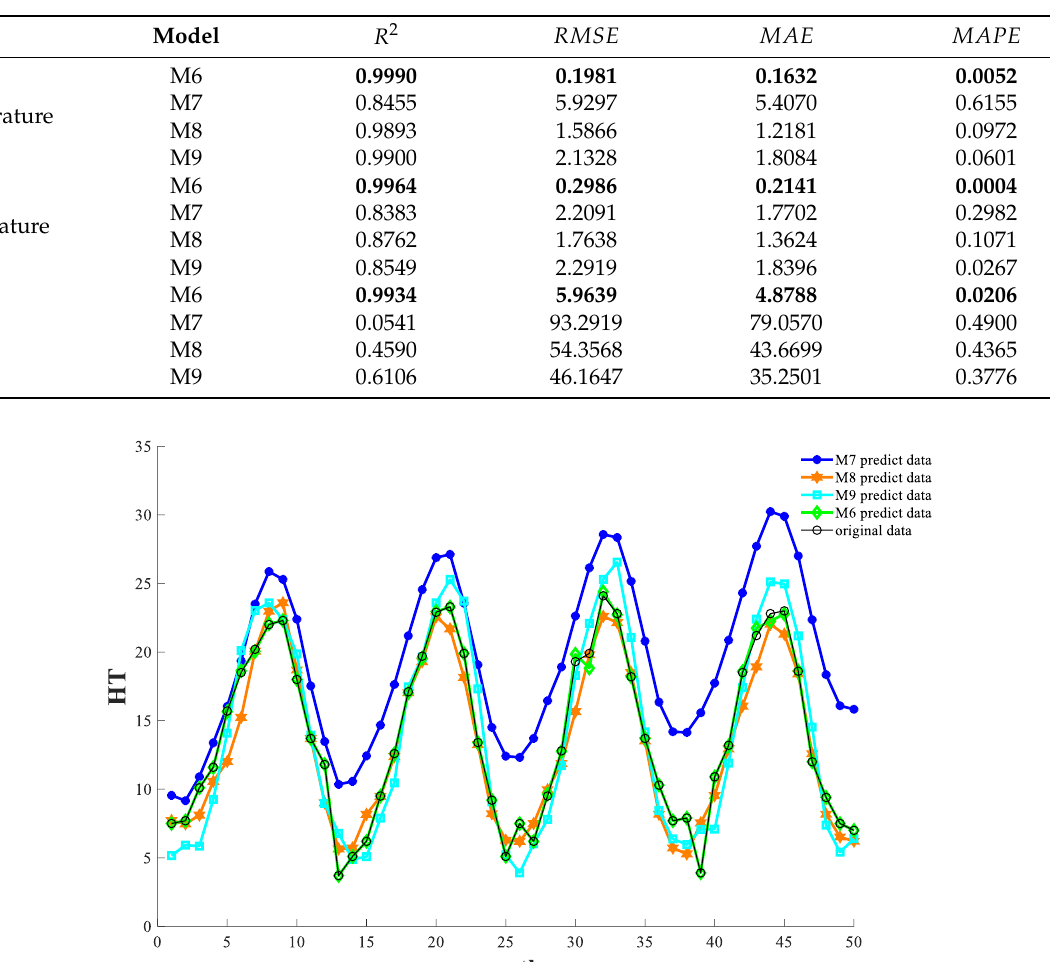
Table 4. Performance evaluation indices for M6–M9 models in testing dataset.